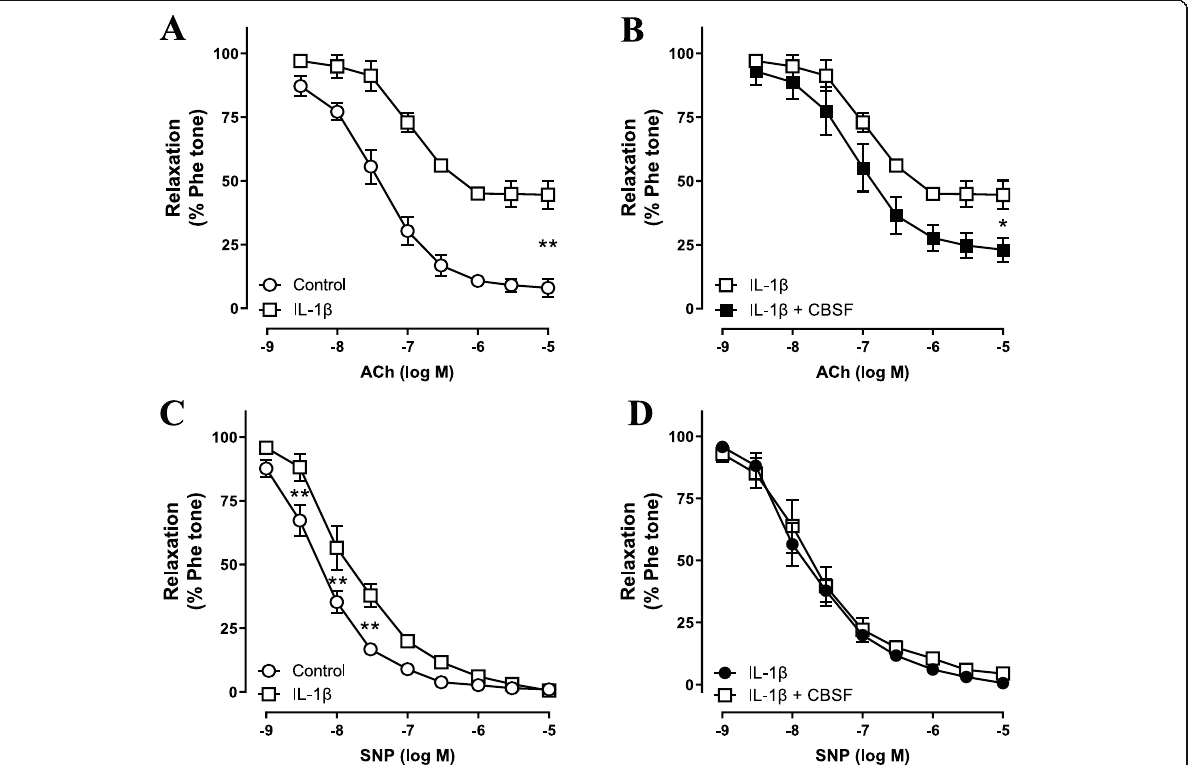
Fig. 5 Ex vivo CBSF co-incubation remedied IL-1 β -impaired EDR in C57BL/6J mouse aortae. Effect of IL-1 β (1 pg/mL) incubation on EDR